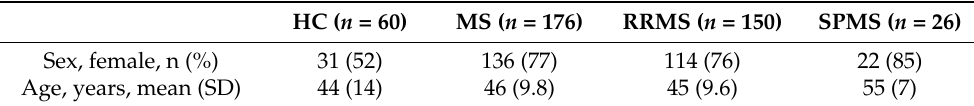
Table 1. Data of healthy controls and patients with multiple